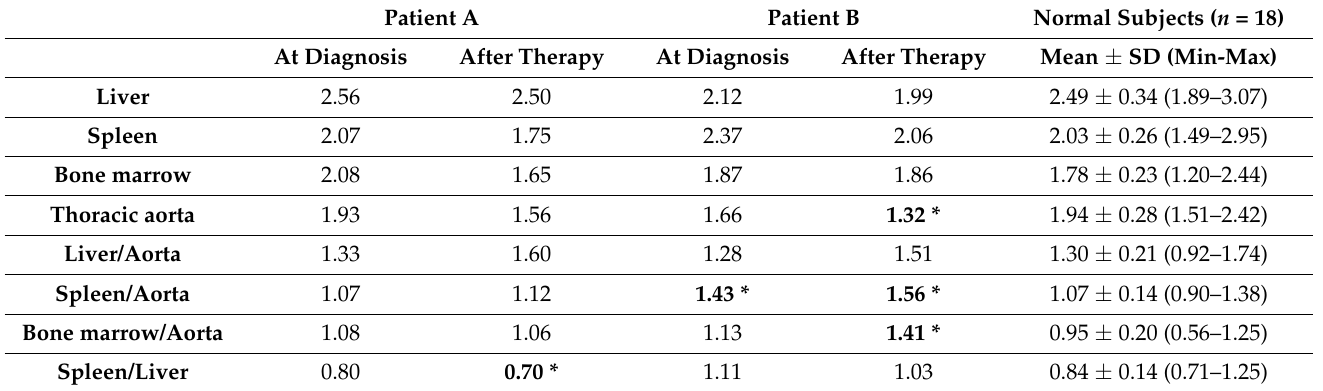
Table 2. Values of SUV mean in different tissues in the patients before and 14 days after the Tocilizumab, as compared to the control